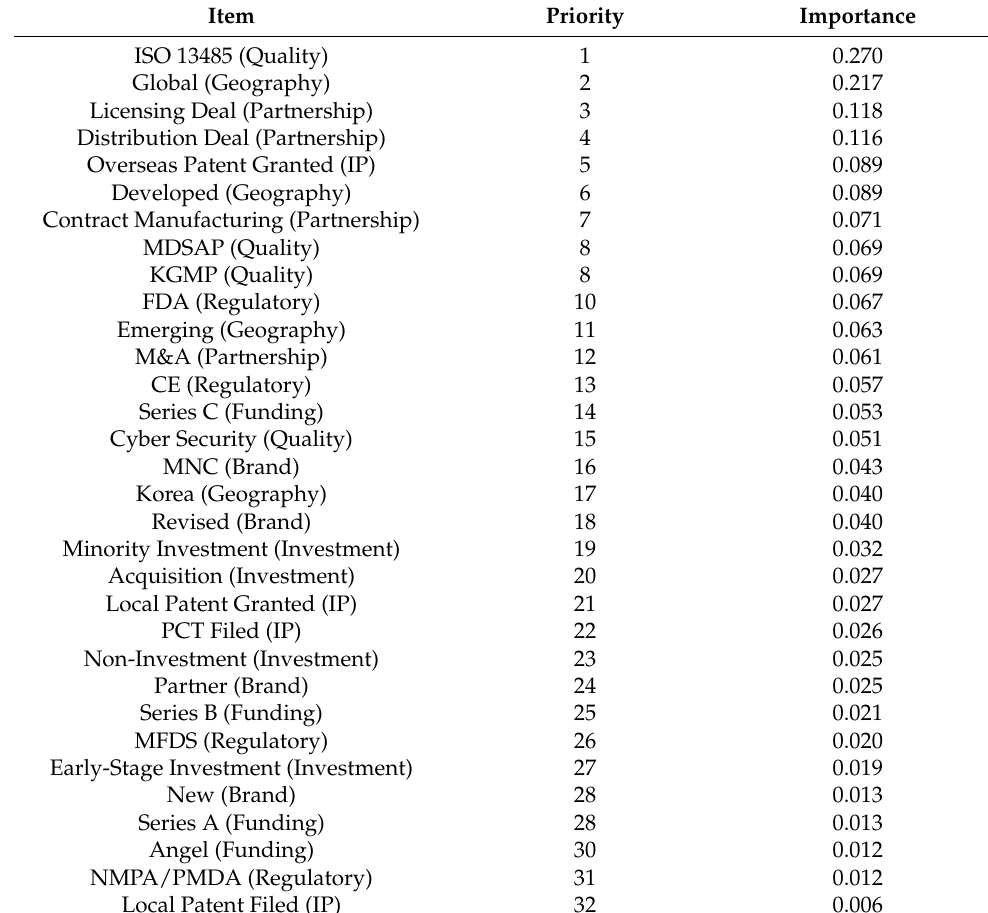
Table 2. Results of internal and external conditions.